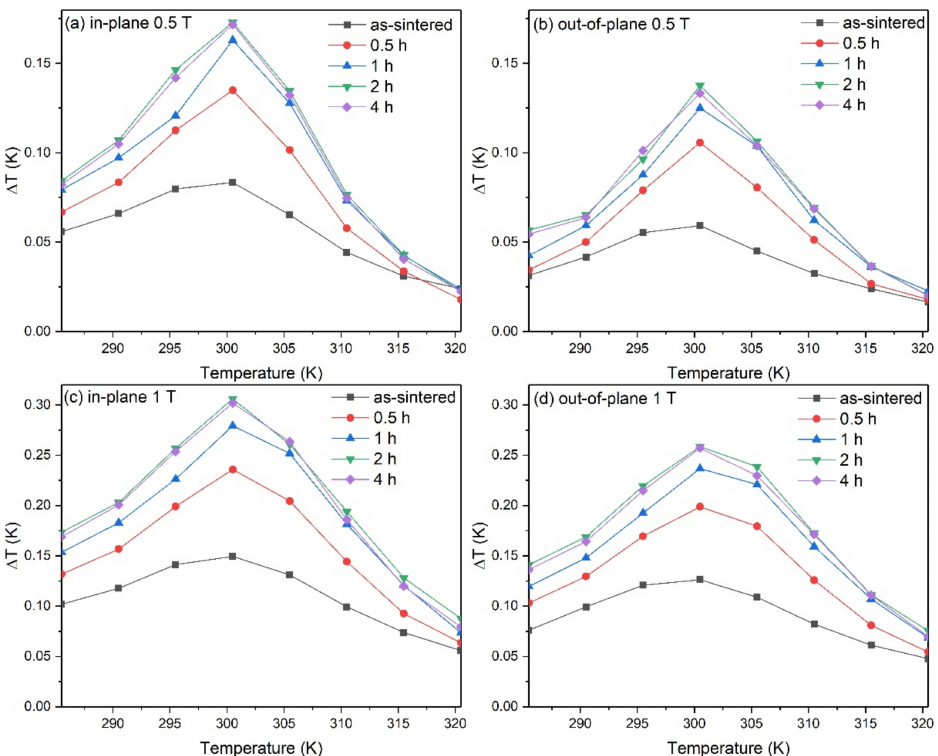
Figure 10. Direct MCE measurement under ( a , c ) in-plane and ( b , d ) out-of-plane magnetic field of the CoFe-coated alloys compared to the as-sintered